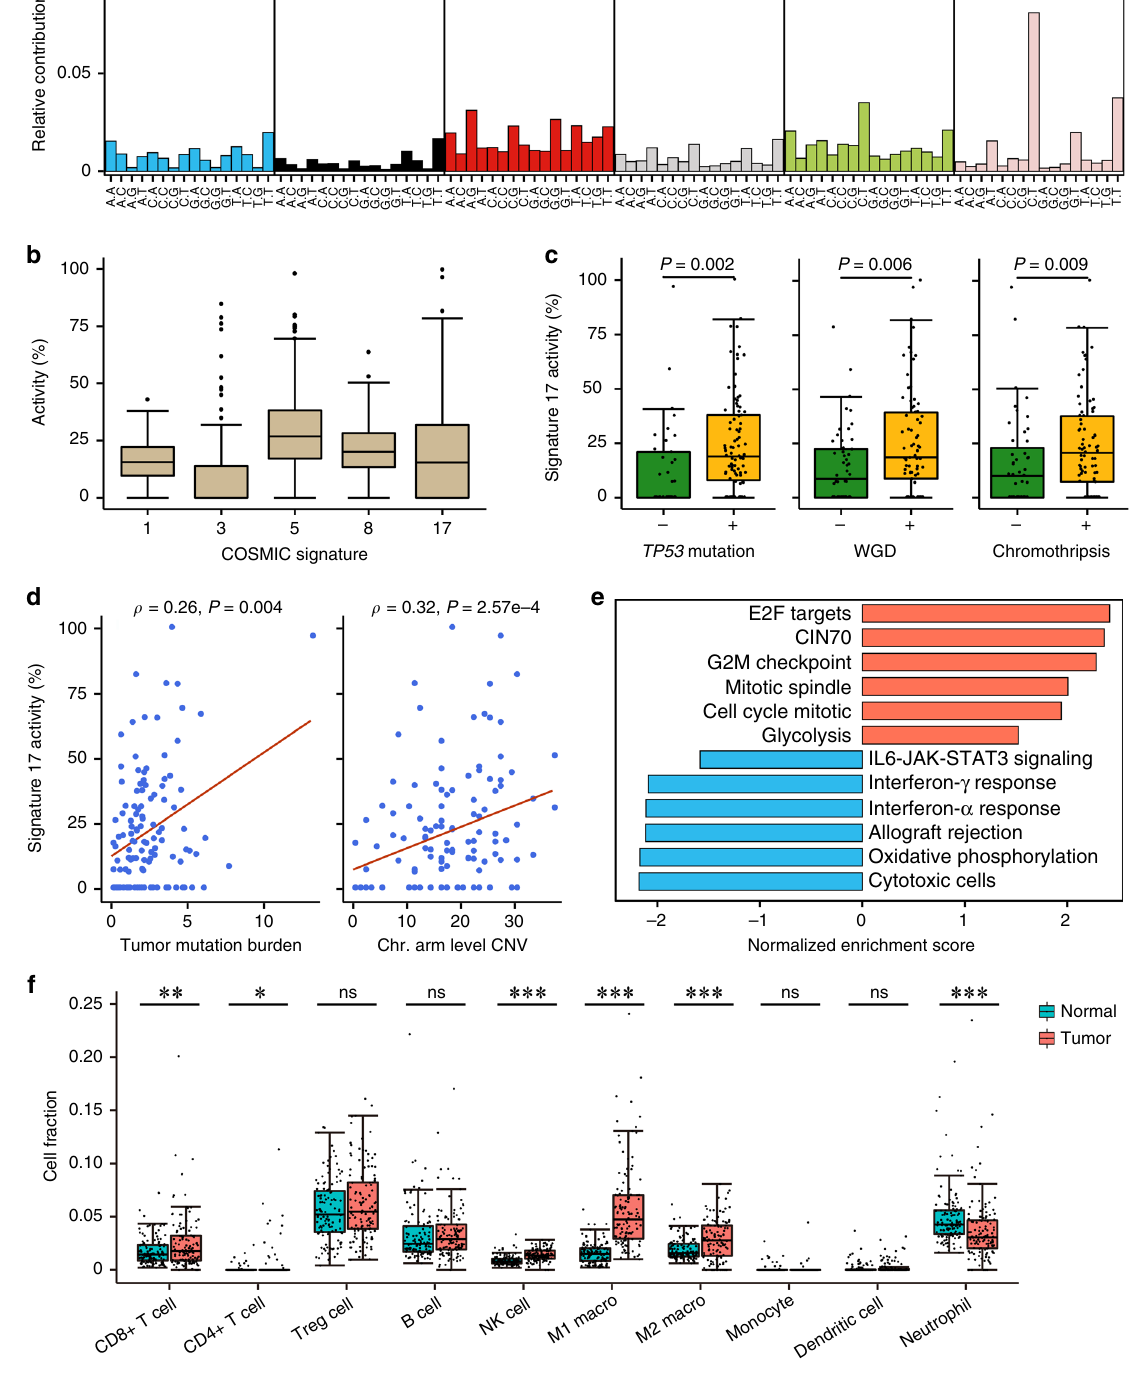
Fig. 2 Genomic and transcriptomic features associated with COSMIC Signature 17. a Mutational spectra of our ACGEJ samples. Different colors represent six SBS categories. On the x -axis, 16 possible trinucleotide contexts are repeated for each SBS category. b Distributions of COSMIC Signatures 1, 3, 5, 8, and 17 activities in 124 ACGEJ genomes. c Box plots comparing Signature 17 activities in ACGEJ samples with and without TP53 mutations ( n = 88 and 36, respectively), WGD ( n = 74 and 50, respectively), or chromothripsis ( n = 77 and 47, respectively); P values derived from two-sided Wilcoxon rank-sum tests. d Spearman ’ s correlations between Signature 17 activities and TMB or chromosomal (Chr.) arm level CNVs in ACGEJ. e Pathways or gene signatures enriched with genes positively (red bars) or negatively (blue bars) correlated with Signature 17 activities. f Box plots comparing the fractions of ten immune cell types in total cells between 124 pairs of ACGEJ and matched adjacent normal tissue samples. * P < 0.05; ** P < 0.01; *** P < 0.001; ns, not signi fi cant of two-sided Wilcoxon rank-sum test; macro., macrophage. Box plots show the median (central line), the 25 – 75% interquartile range (IQR) (box limits), the ±1.5 times IQR (Tukey whiskers), and outliers ( b ) or all data points ( c, f ); the lowest and the highest data points indicate minimal and maximal values,